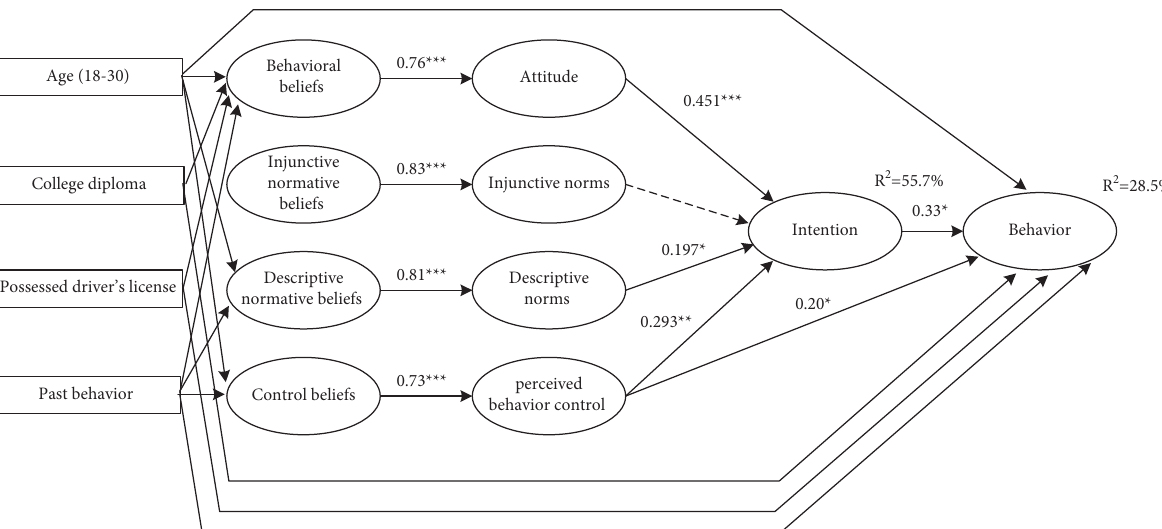
Figure 5: TPB model for e-bike couriers’ traffic violation behavior and the effects of the demographic variables.